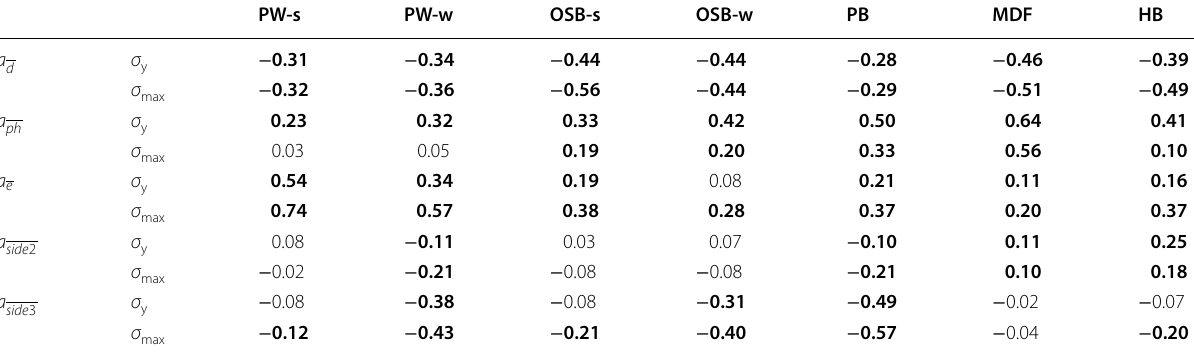
Table 3 Values of the partial regression coefficient